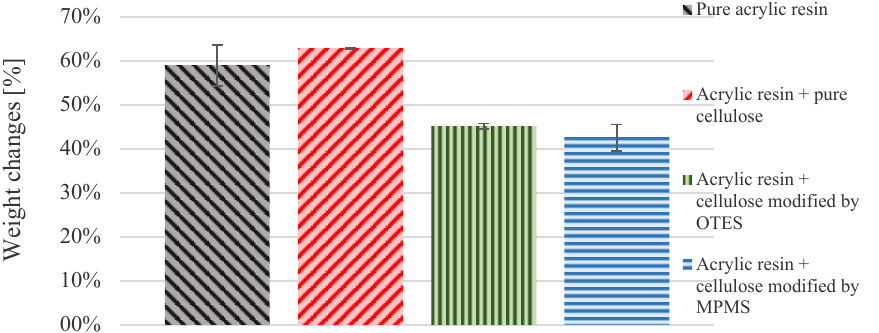
Figure 8. Weight changes (%) of analysed samples.